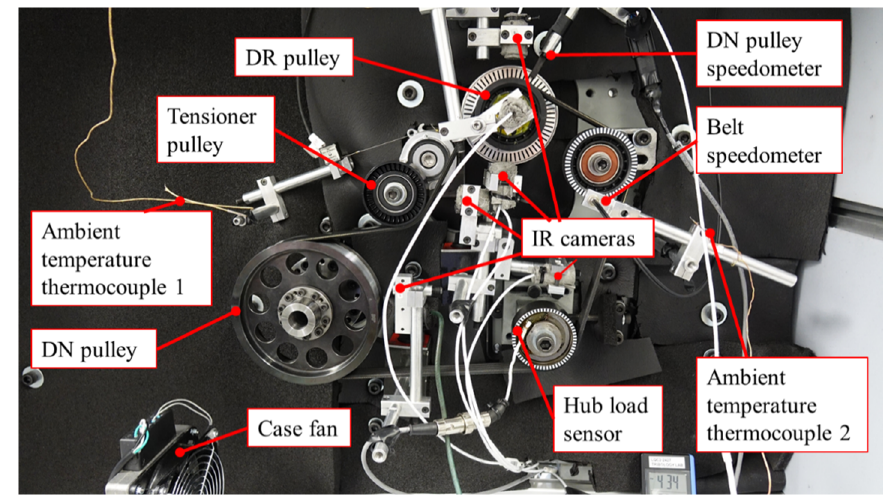
Figure 12. Experimental installation of belt drive system based on designed layout.